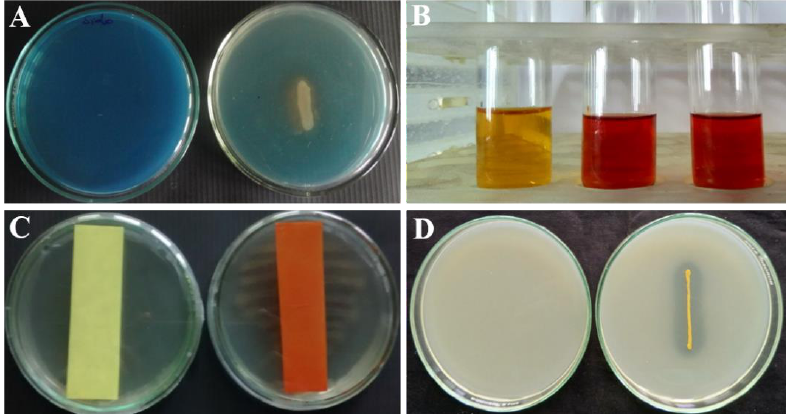
Figure 2. Secondary metabolites produced from P. fluorescens VSMKU3054. ( A ) siderophore, ( B ) indole acetic acid, ( C ) hydrogen cyanide & ( D ) phosphate solubilization.